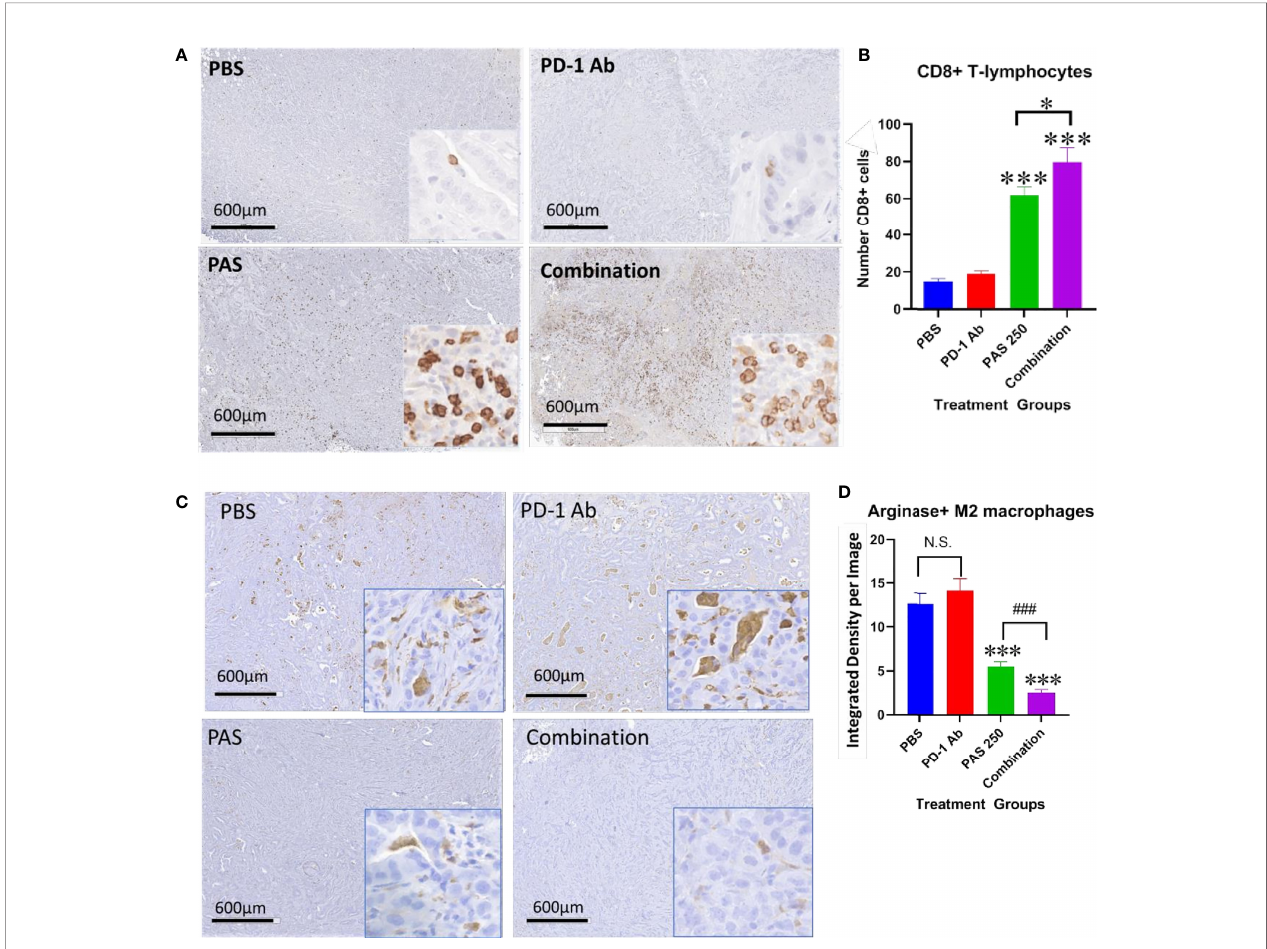
FIGURE 5 | PAS monotherapy and in combination with PD-1 Ab alter the tumor immune cell signature. (A) Representative low magni fi cation tumor from each treatment or control group (scale bar 600µm) and a higher magni fi cation (20×; Box insert) of tumors stained with an antibody for CD8+ T-lymphocytes. (B) Columns represent the mean ± SEM of the number of CD8+ immunoreactive cells in sections of YTN tumors from each group. PAS monotherapy and in combination with a PD-1 Ab signi fi cantly increase the number of CD8+ immunoreactive T-cells in the YTN tumors compared to tumors of PBS-treated mice. The combination of PAS with PD-1 Ab also markedly increased the number of CD8+ cells compared to PAS monotherapy. (***P <0.001 compared to PBS; ### P <0.001, compared to PAS). (C) Representative low magni fi cation tumor from each treatment or control group (scale bar 600µm) and a higher magni fi cation (20X; Box insert) of tumors stained with and antibody for M2-polarized tumor-associated macrophages (TAMs). (D) Columns represent the mean ± SEM of integrated density from ImageJ analysis for concentration of M2-polarized TAMs. The number of TAMs decreased signi fi cantly in tumors of mice treated with PAS monotherapy or in combination with the PD-1 Ab. Analysis showed that the combination therapy reduced TAMs signi fi cantly more than PAS alone. (***P<0.001 compared to PBS; ### P<0.001, compared to PAS). NS, not signi fi